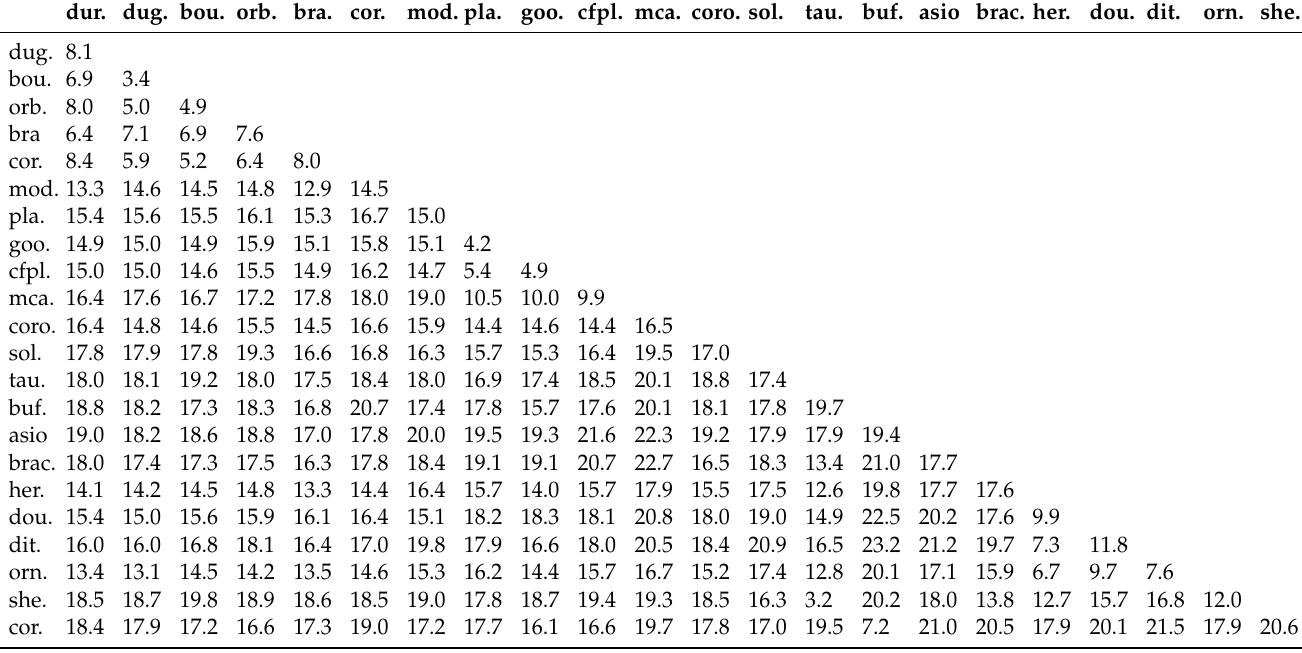
Table 1. Mean genetic distances (in %) of the taxa of Phrynosoma based on the ND4